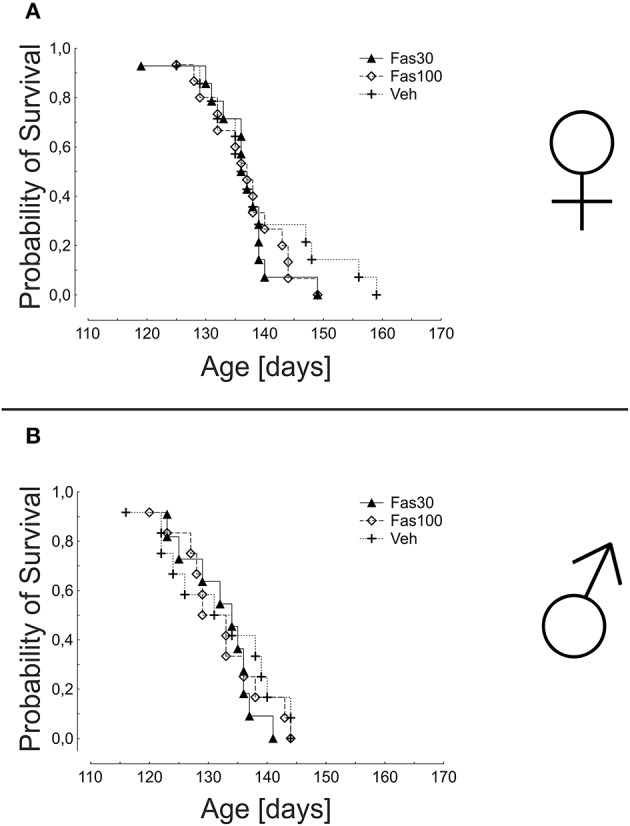
Survival in SOD1G93A mice treated with 30 mg/kg Fasudil (Fas30), 100 mg/kg Fasudil (Fas100), or with vehicle (Veh). Depicted is the cumulative probability of survival of female (Fas30 n = 14, Fas100 n = 15, Veh n = 14) (A) and male (Fas30 n = 11, Fas100 n = 12, Veh n = 12) (B) mice.